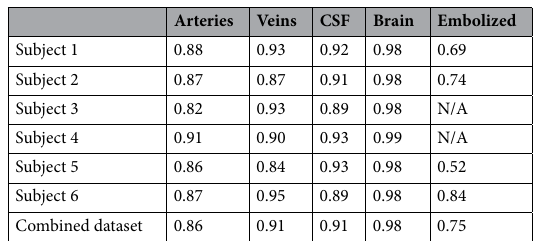
Table 1. Dice similarity coefficients for each tissue class and for each subject in the validation data set.